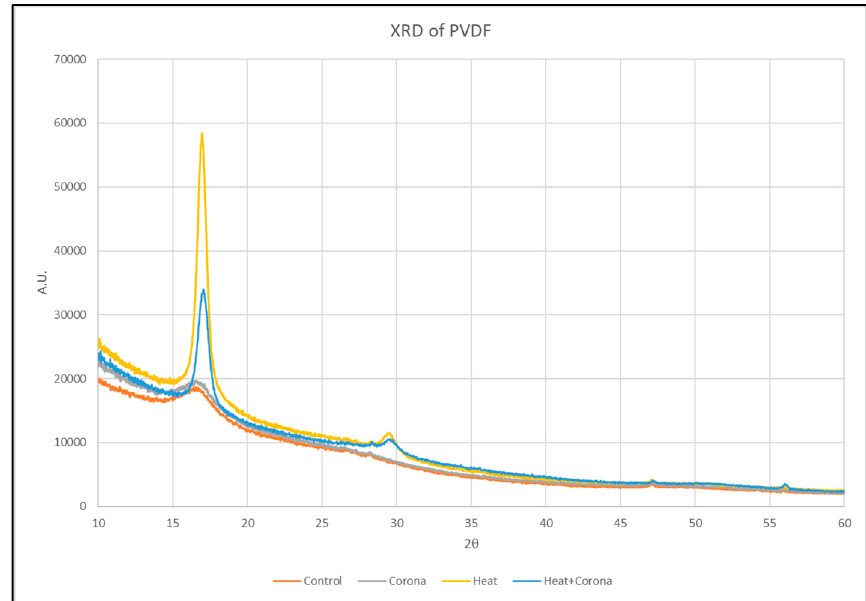
Figure 8. XRD of control and treated PVDF nanofibers .